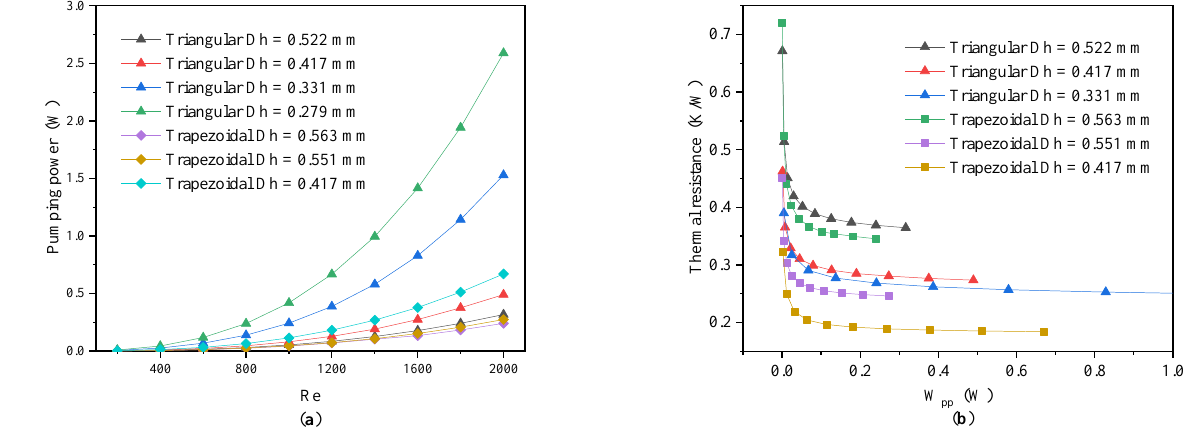
Figure 10. The variation of W pp ( a ) and thermal resistance ( b ) for triangular and trapezoidal micro- channel heat sinks. crochannel heat